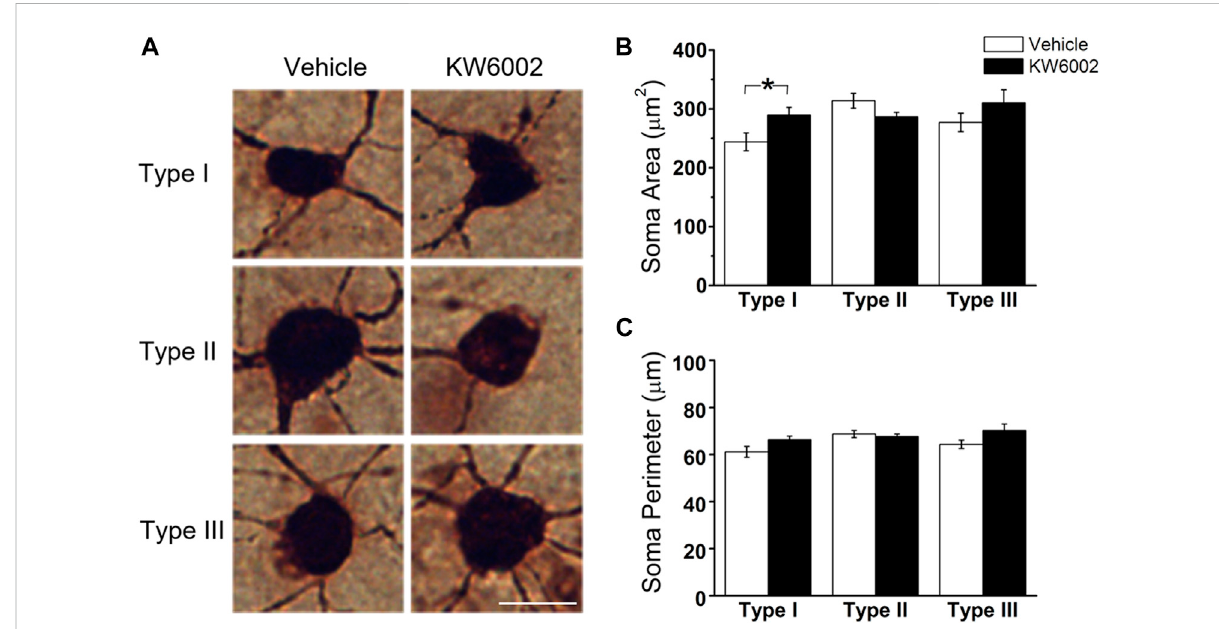
FIGURE 2 The effect of KW6002 on the somatic morphology of the three RGC types during the development. (A) Representative pictures of somata in each RGC type examined from vehicle -treated and KW6002-treated group. Scale bar, 20 μ m. (B , C) Comparative analysis of soma area (B) and perimeter (C) of different RGC types between vehicle-treated and KW6002-treated mice. Data represent mean ± SEM. * p <